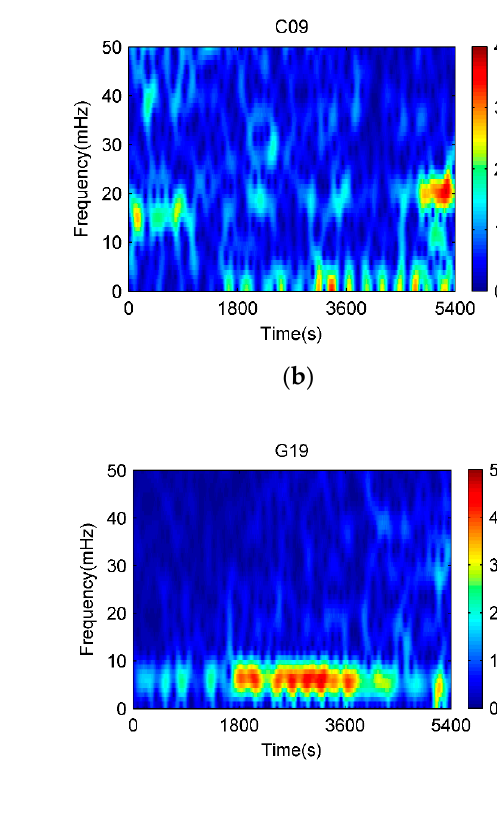
( b ) Figure 4. PSD of code multipath (from 9:00 a.m. to 10:30 a.m. local time in DOY 310). ( a ) C04 and C09; ( b ) C11 and G19. In order to observe temporal changes of multipath central frequencies, frequency spectrum is used and the time-frequency distribution of satellite multipath is shown in Figure 5. It descripts multipath spectrum energy distributions in both time and frequency fields. BDS GEO C04 satellite exhibits an even energy spectrum distribution. This implies